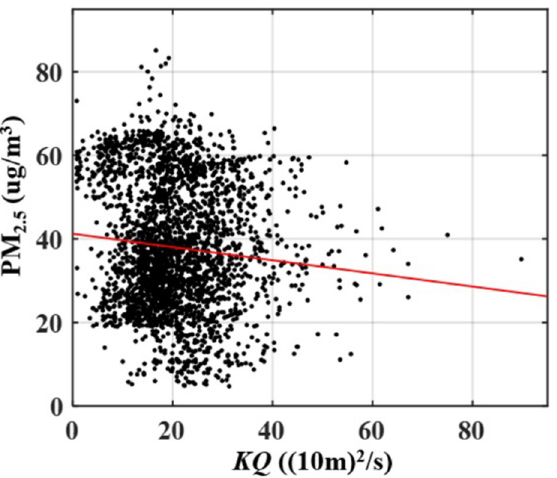
Fig 7. Scatter diagram and regression line of the correlation between PM 2.5 and air flow coefficient ( KQ ).